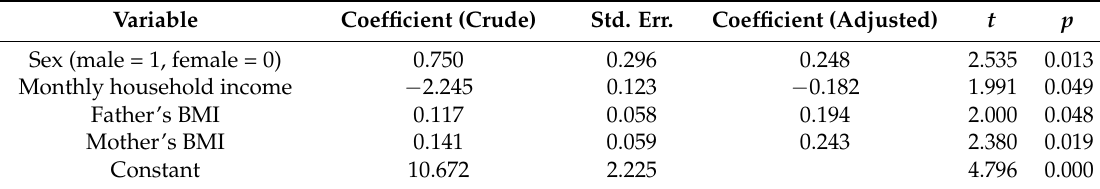
Table 3. Factors associated with BMI among preschool children identified by a multiple linear regression ( n =